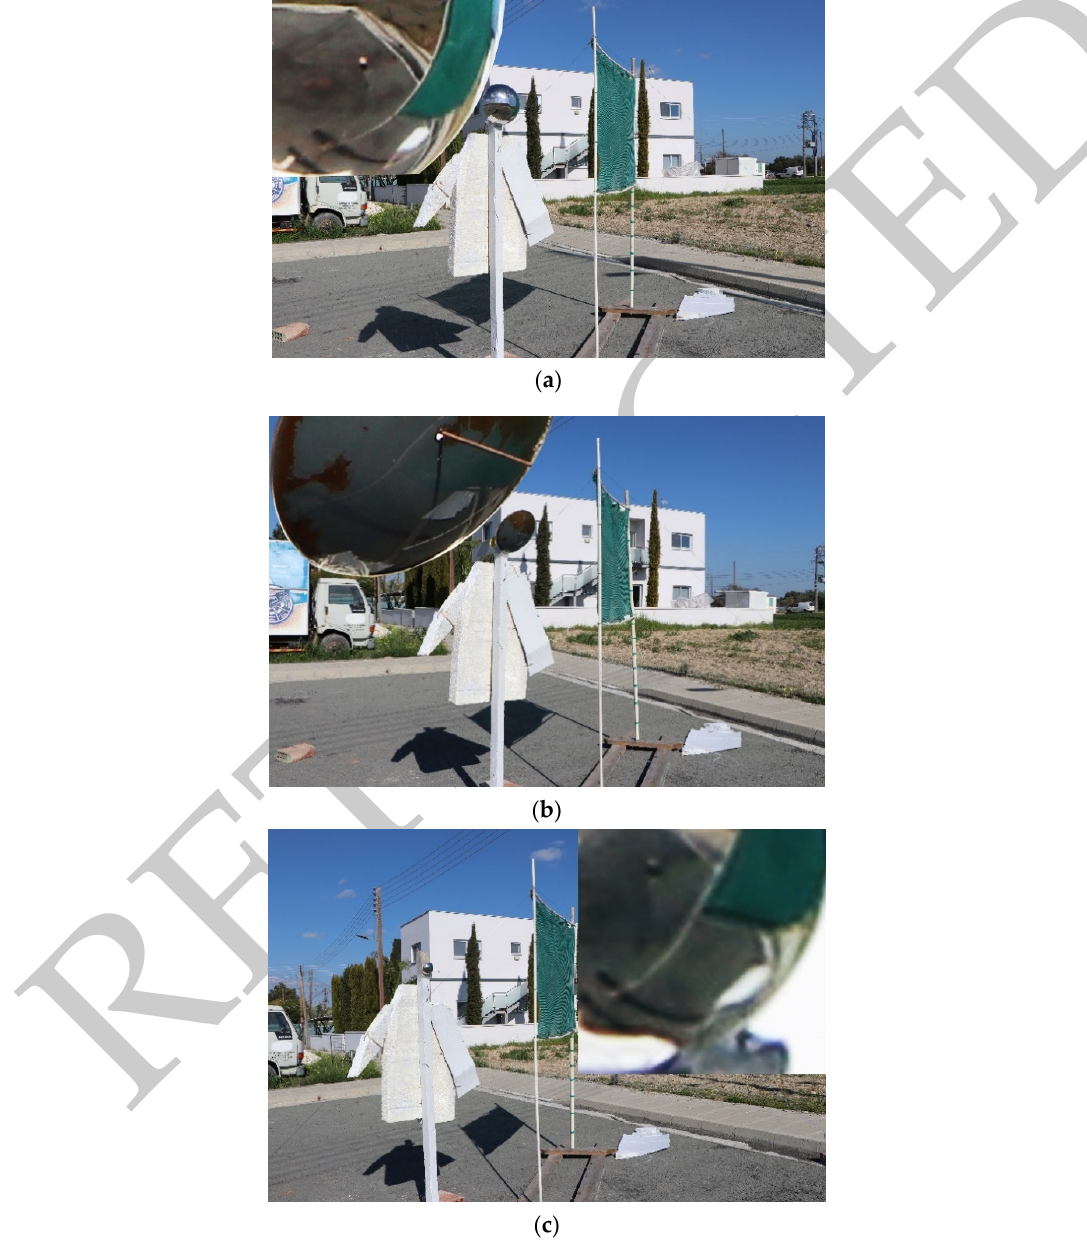
Figure 24. Reflections with different diameters of mirrors: ( a ) spherical surface, 0.29 m diameter; ( b ) spherical surface, 0.64 m diameter; ( c ) spherical surface, 0.11 m diameter. For better clarity, the inset in each photo shows an enlargement of the cardboard ‘shadow’ and the base of the pole. Essentially, the relative position of objects is not affected, although an enlargement is produced by greater diameter mirrors and visa-versa.